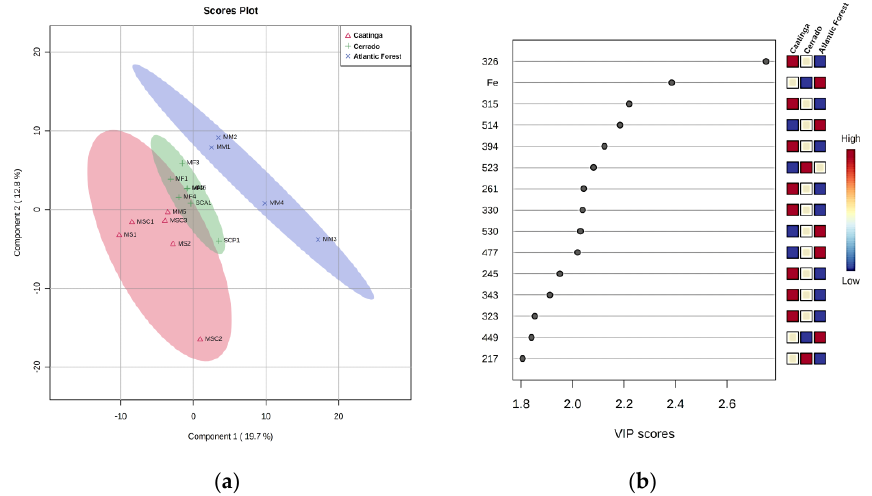
Figure 1. Discriminant analysis of SBH based on Brazilian biogeographical zones. ( a ) PLS-DA score plots; and ( b ) VIP score of physicochemical parameters, mineral profile, antioxidant capacity, and mass fingerprint analysis of SBH.